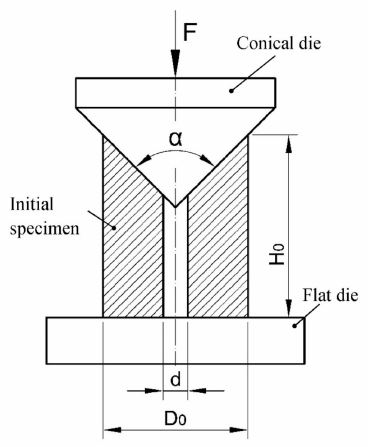
Figure 1. Experimental